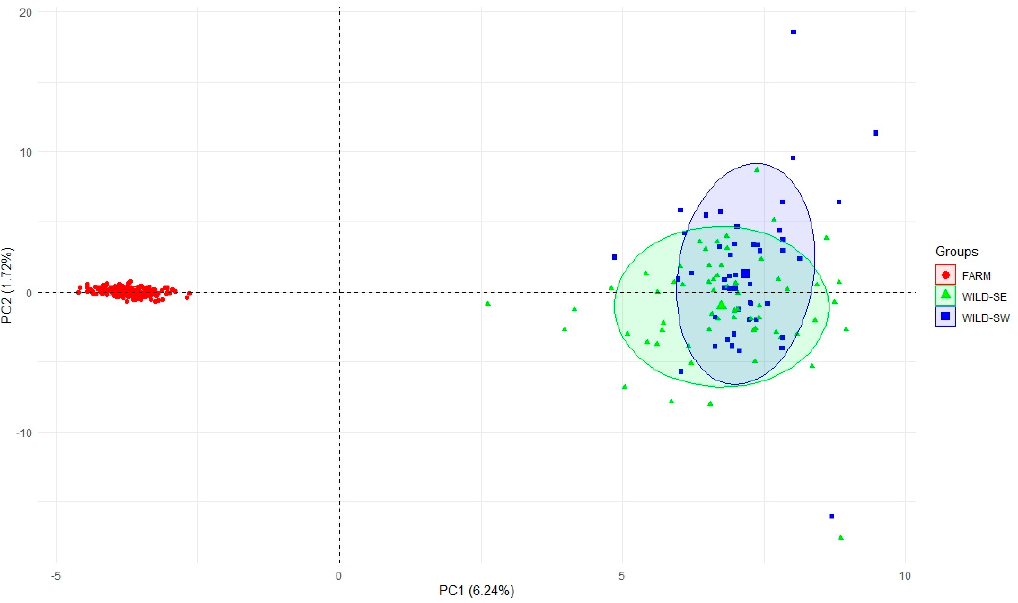
Figure 4. Cluster composition and population differentiation of the studied red foxes.